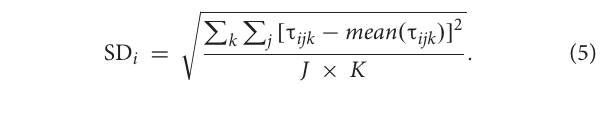
TABLE 3 | RMSE, SD, average 68.2% HWCI, mean defect, loss variance and corrected loss variance of the estimated VFM from the qVFM-DSM, qVFM-PDM